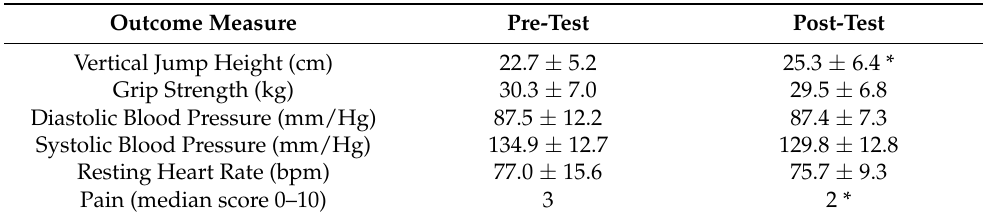
Table 3. Measures of muscle function, cardiovascular output, and self-reported pain. All values are means ± standard deviations (except ordinal pain scale data reported as median). * = significantly different from the pre-test at ( p < 0.05).